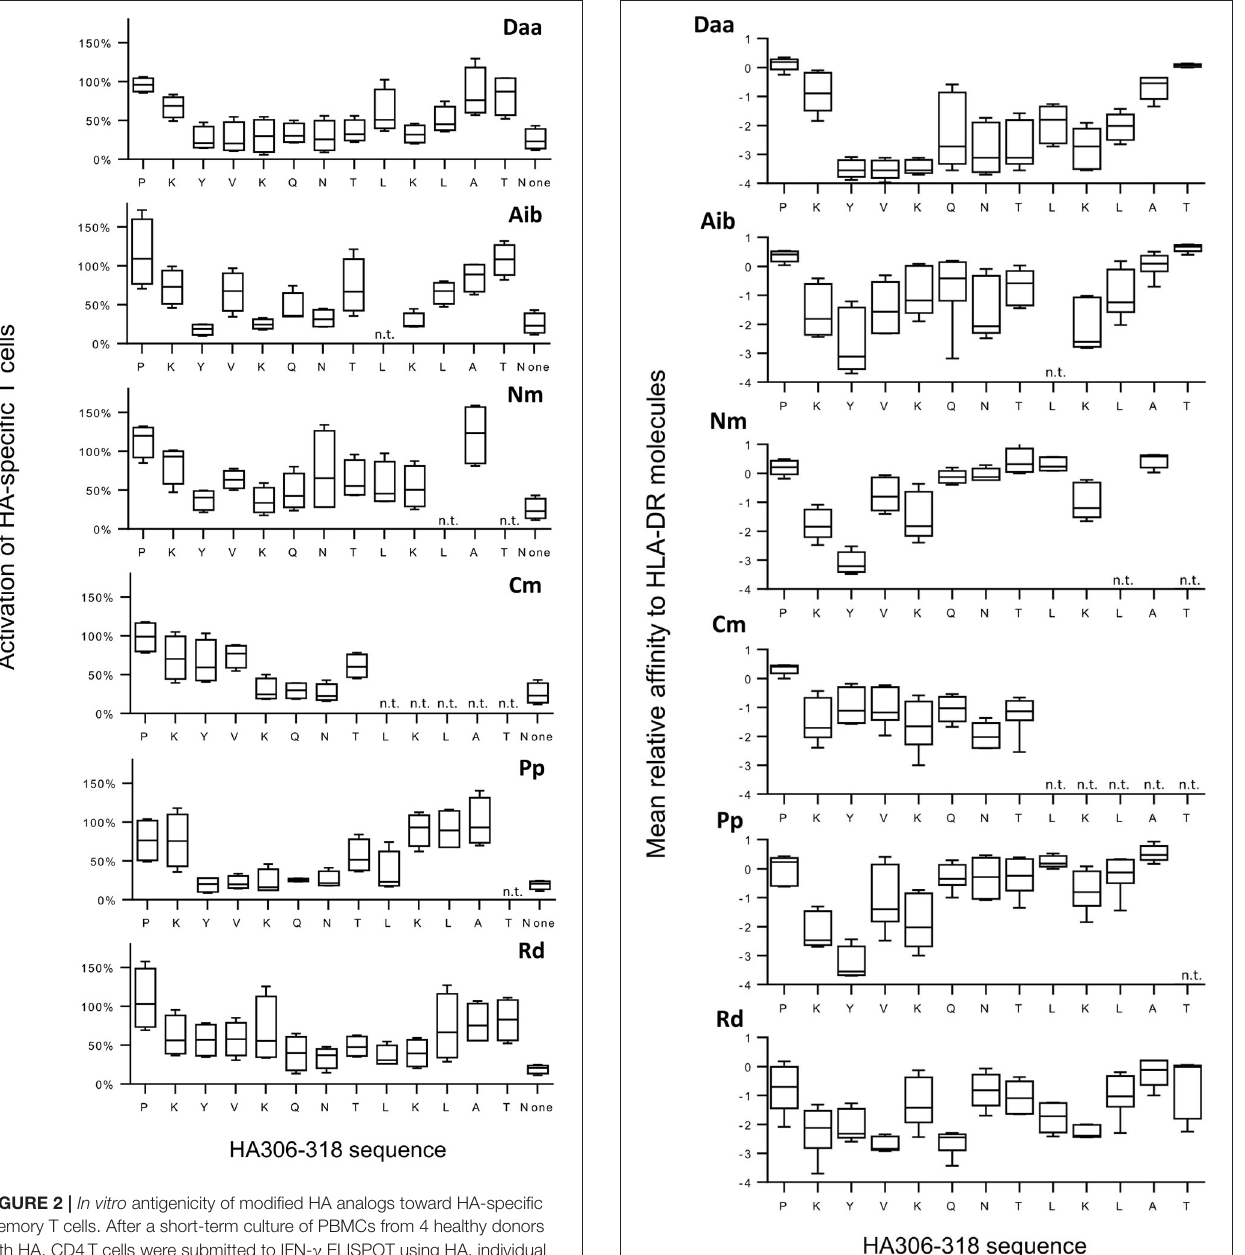
with HA-specific T cells of each analog as a function of its mean relative affinity for the 5 HLA-DR molecules ( Figure 4 ). A good correlation was found for Daa ( ρ = 0.9648), Aib